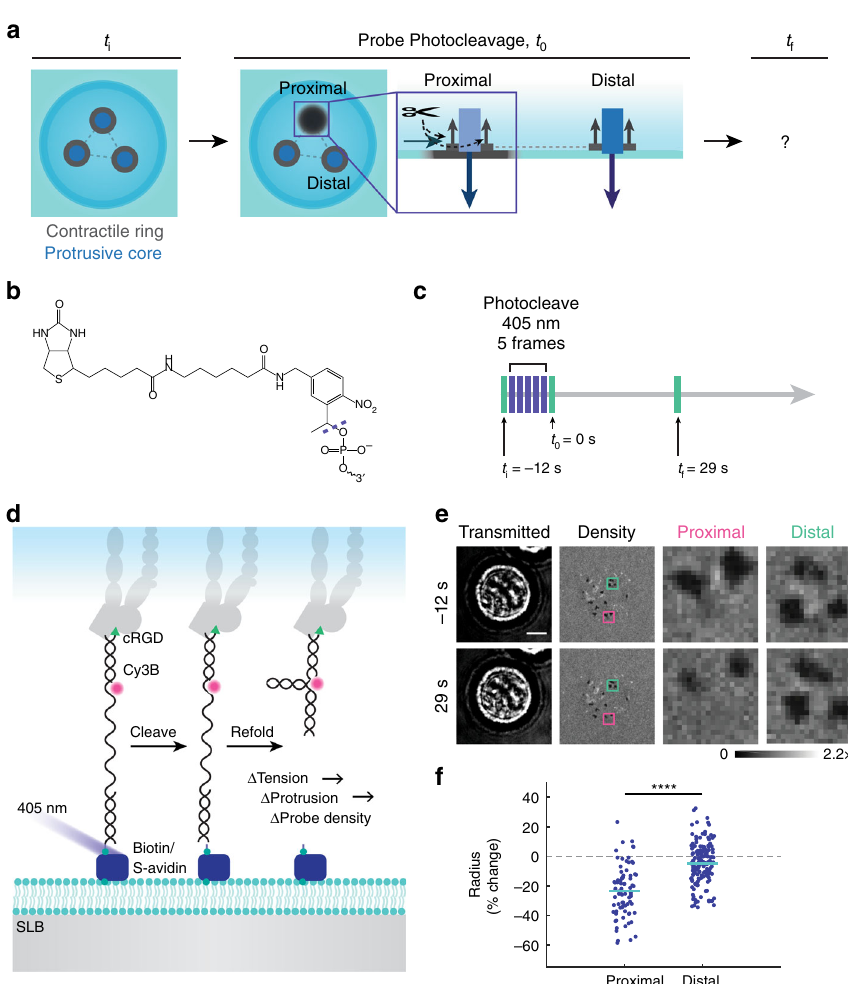
Fig. 5 Loss of integrin ring tension causes local podosome retraction. a To test how the podosome network responds to perturbations in podosome tension, probes were photocleaved under individual podosomes or podosome clusters, and the proximal and distal responses were monitored. b Chemical structure of PC Biotin, which was incorporated at the 5 ′ termini of 4.7 pN hairpins. c Cells were imaged before and after fi ve sequential frames of probe photocleavage with a 405 nm laser. d Schematic of photocleavable protrusion probes. When the biotin anchor is cleaved with a 405 nm laser, the probe detaches from the bilayer and refolds, severing the podosome ’ s mechanical connection to the SLB. Cy3B intensity reports probe density, and therefore serves as a marker of core size. e Representative images of cells and podosomes before ( − 12 s) and after (29 s) photocleavage. Proximal pink boxes indicate the entire region of photocleavage. Distal green boxes show a representative region across the cell. f Summary statistics showing the percent change in podosome radius as measured by Cy3B depletion in regions cleaved by the 405 nm laser (proximal) and all other regions of the cell